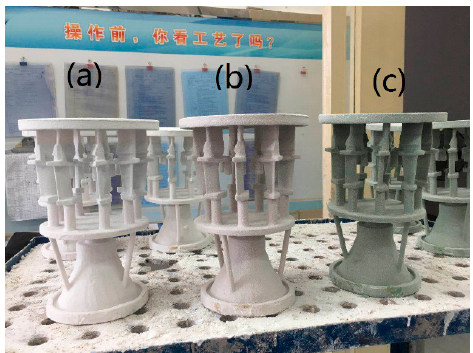
Figure 1. Photos of ( a ) fused alumina facecoat; ( b ) 2 wt.% h-BN added facecoat and (c) 2 wt.% Cr 2 O 3 added facecoat.